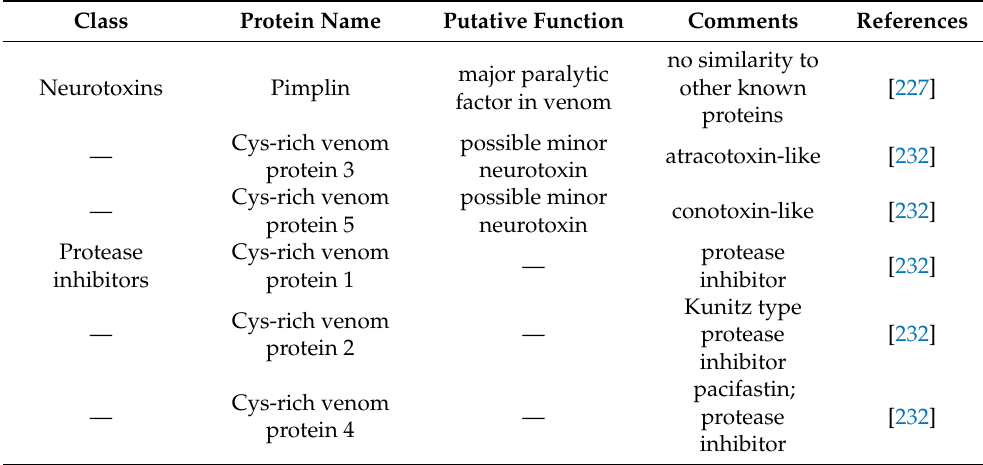
Table 9. Summary of major protein components identified in the venom of Pimpla rufipes